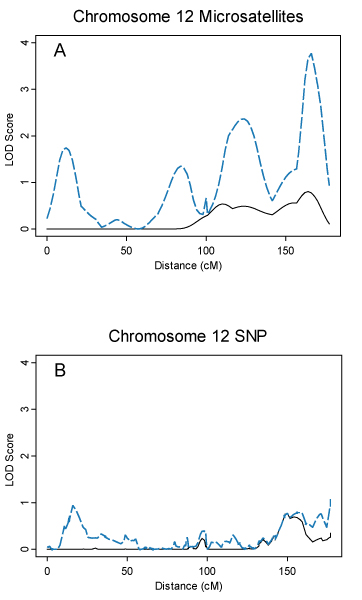
Affected-relative-pair linkage analysis with P300 amplitude as a covariate. Linkage results (LOD scores plotted over distance in centimorgans (cM)) are shown for MS markers (A) and SNPs (B). Solid line indicates the baseline model with ALDX2 as a binary trait, in only those individuals with P300 data available. Dashed line indicates model with P300 as a covariate. Sample sizes are 204 ARPs for MS, 200 for SNP data.